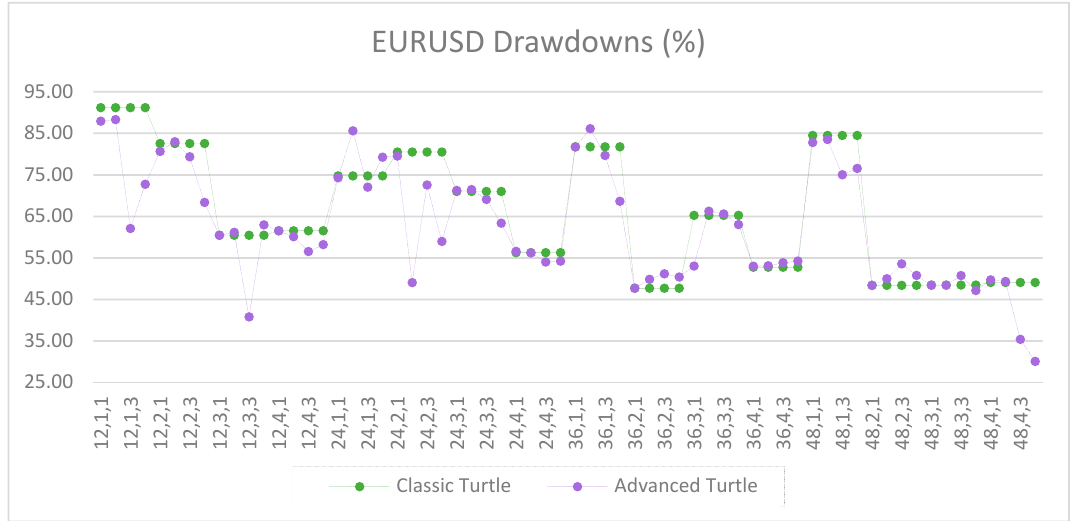
Figure A19. Net profits of EURUSD between the classic and the advanced Turtle systems for every combination of N, X, Y for the medium parameters (40, 80).